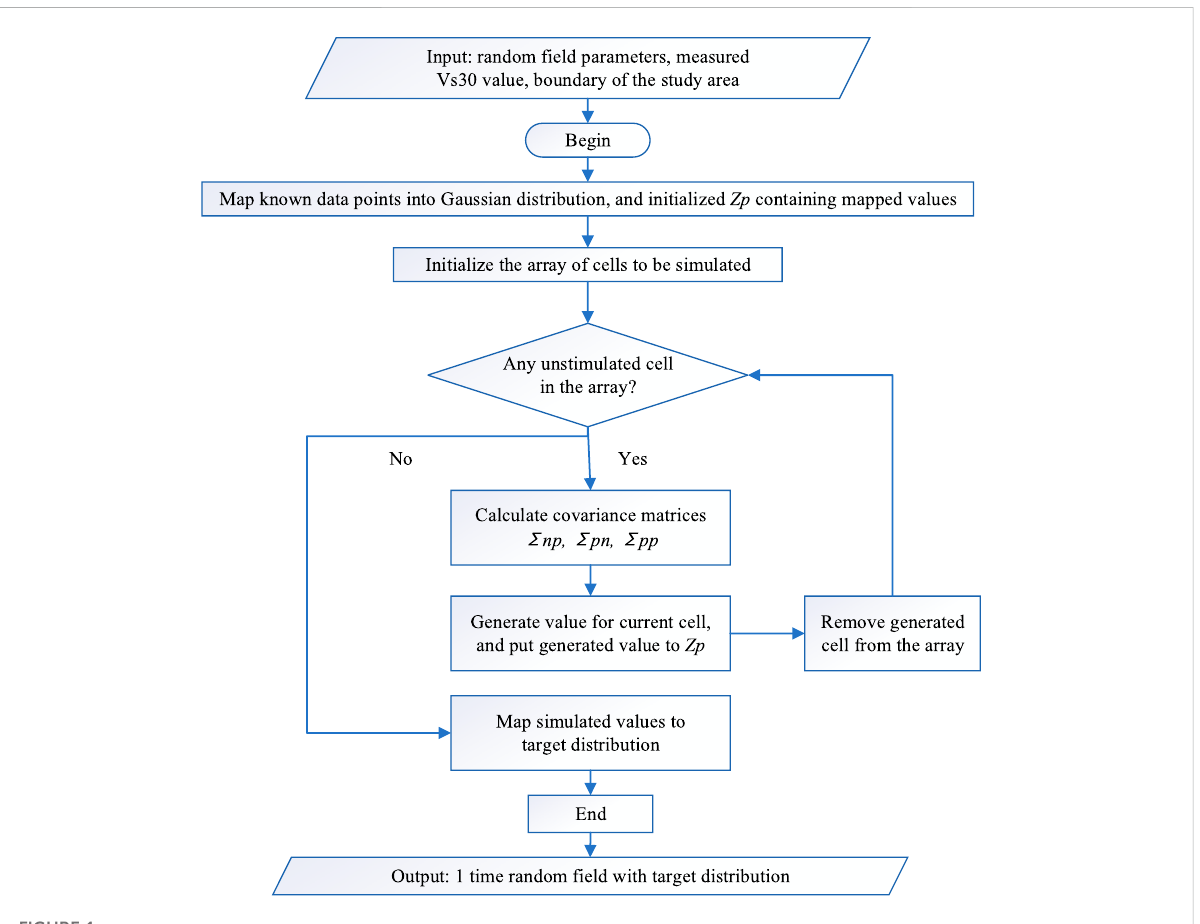
Flowchart of the random fi eld model